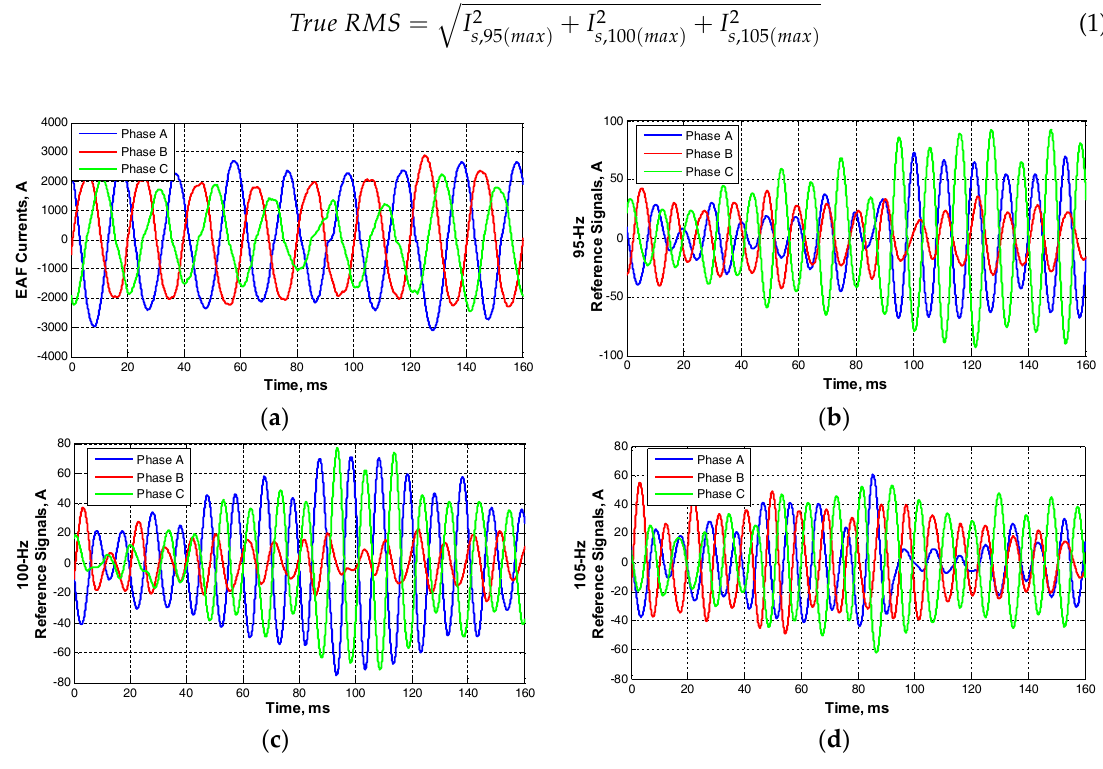
Figure 5. EAF line currents on MV side ( a ) a sample line current waveforms collected in the field at a sampling rate of 25.6 kS/s and ( b ) 95-Hz components ( c ) 100-Hz components, and ( d ) 105-Hz components obtained from field data by MSRF analysis in real-time.